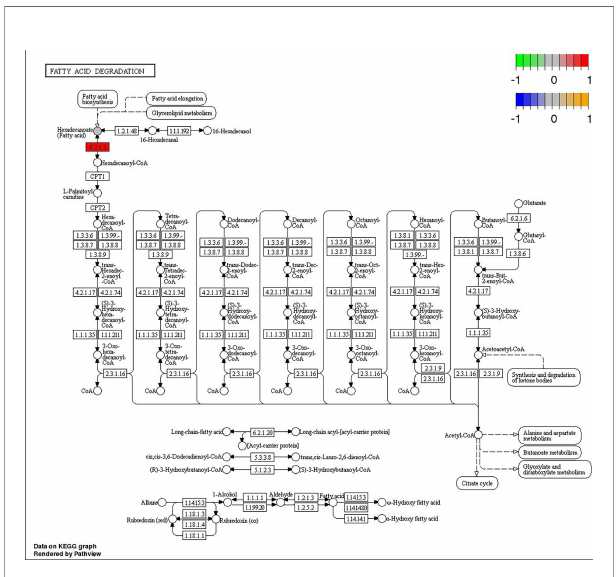
FIGURE 6 | Changes in the fatty acid degradation pathway in Ctenopharyngodon idella brain after 2-phenoxyethanol (2-PE) high- concentration